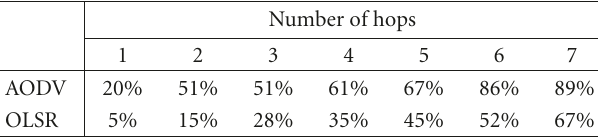
Table 2: Medium-scale testbed: average packet loss for di ff erent numbers of hops.